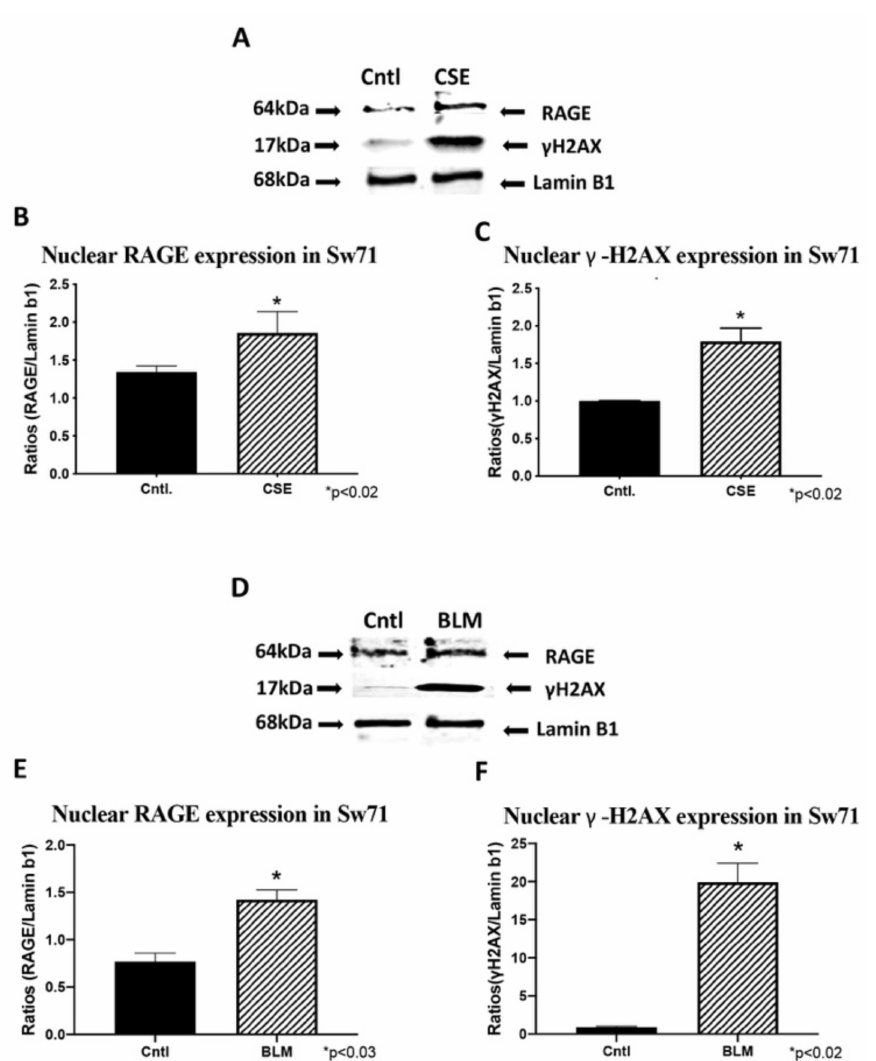
Figure 6. Trophoblast cell, Sw.71, DNA-DSBs and RAGE (WB). ( A ) Characteristic western blot for γ -H2AX and RAGE in CSE treated Sw.71 cells. ( B , C ) Elevated γ -H2AX and RAGE protein expression in CSE treated cell samples when compared to controls. ( D ) Characteristic western blot for γ -H2AX and RAGE proteins in BLM treated Sw.71 cells. ( E , F ), Elevated γ -H2AX and RAGE protein expression in BLM treated cell samples when compared to